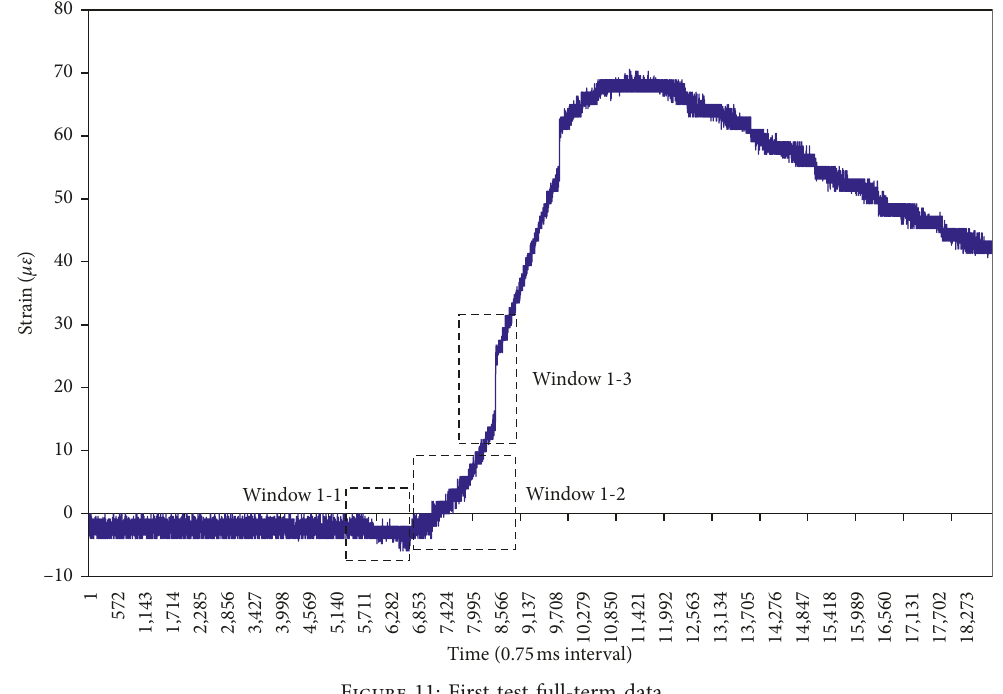
Figure 11: First test full-term